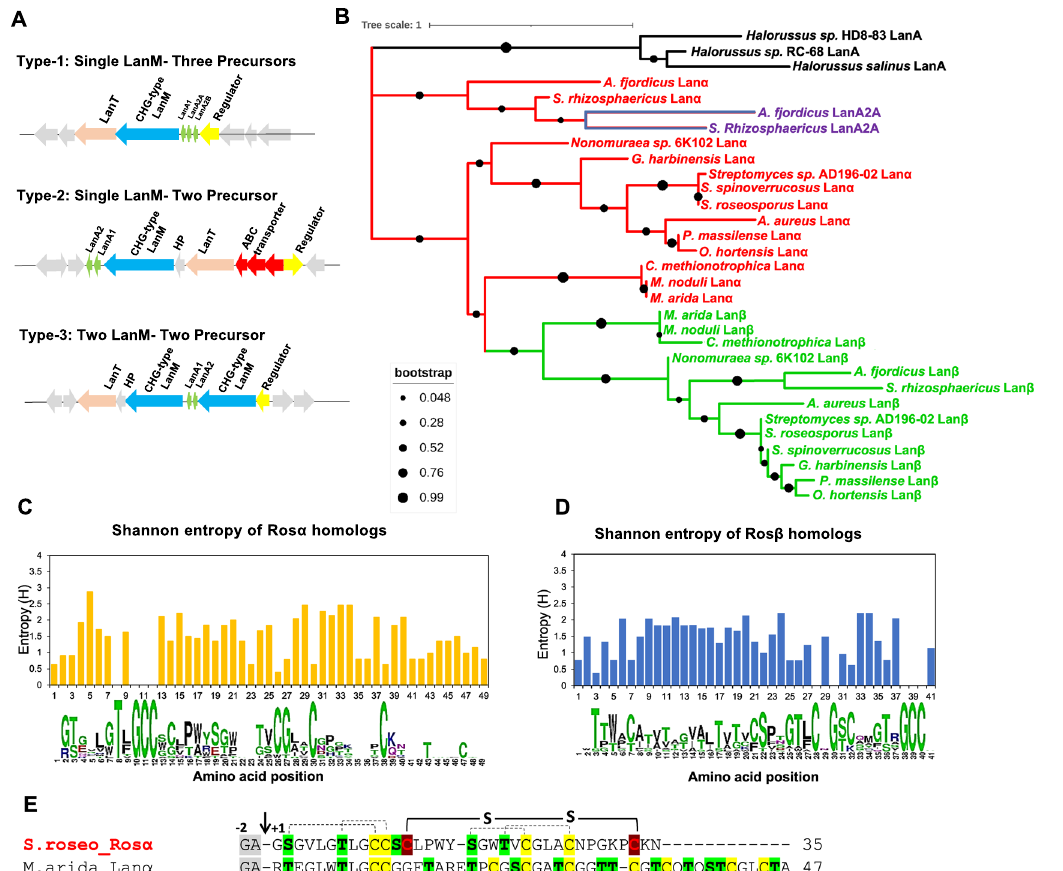
Fig. 3 Diversity among the 13 representative members of the roseocin family. A Three common types of BGCs encode roseocin homologs, type-1, type-2, and type-3 BGC examples are of S. rhizosphericus, S. roseosporus NRRL 11379 and C. methinotrophica , respectively. B Phylogenetic tree of lanthipeptide core sequences with ML method with bootstrap values of 500 replicates. The exceptional third precursor (LanA2A) of the single LanM-three precursor i.e. type-1 BGC, is phylogenetically related to alpha peptides. Colour coding in Fig. 3B is red: alpha peptides; green: beta peptides; blue: third precursor core region. C and D Variation in the core peptide sequences as a function of Shannon entropy in the roseocin alpha and beta homologs, respectively. The alpha peptides contain a S/TxxxxTxGCC motif at the N-terminal end, and beta homologs contain a GS/ TxxxxS/TxGCC motif at the C-terminal end. E A gigantic Rosα homolog from the Micromonosporaceae family contains nine Cys and thirteen Ser/Thr residues that may form as many lanthionine rings. Rosα of Streptomyces roseosporus ( S. roseo ) contains an indispensable disulphide bond and four (methyl)lanthionine rings (dotted lines depict the proposed ring topology in Rosα, Singh et al. 2020); M. arida-Micromonospora arida . LanA precursor peptide, LanM modification enzyme, HP Hypothetical Protein, LanT dual function peptidase-domain containing